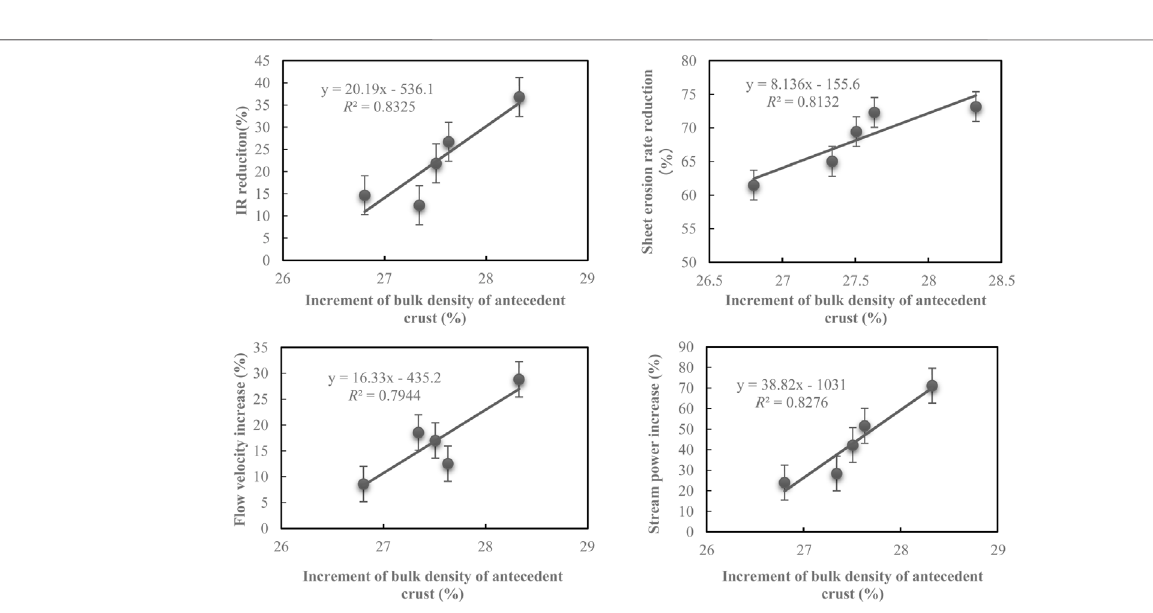
Frontiers in Environmental Science |